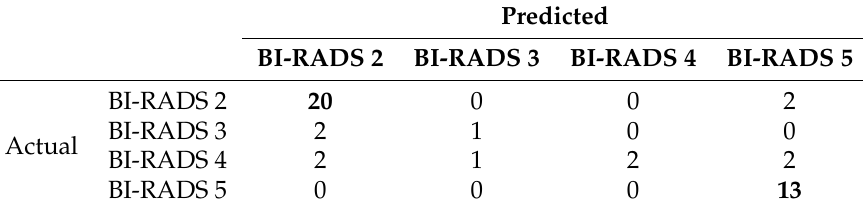
Figure 14. Illustration of confusion matrix. Table 6. SVM confusion matrix.